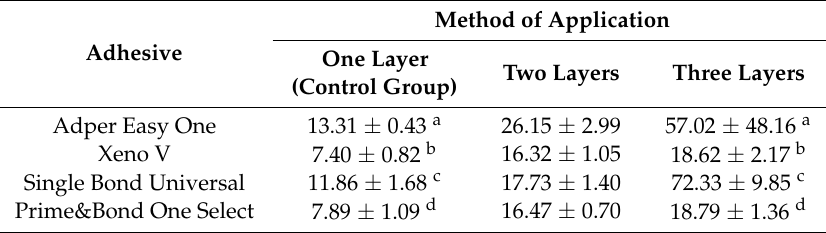
Table 1. The thinnest adhesive layer was obtained for Xeno V applied in 1 layer (control) and the thickest was for Single Bond Universal applied in 3 layers. Table 1. Adhesive layer thickness [µm] (mean values ± standard deviation) of the tested adhesives. Table 1. Adhesive layer thickness [ µ m] (mean values ± standard deviation) of the tested